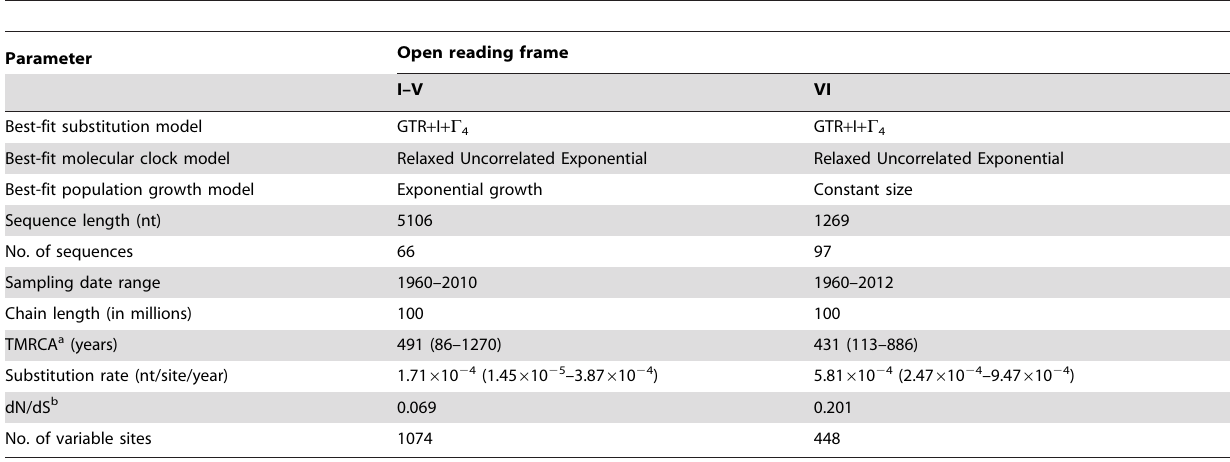
Table 2. Details of the data sets used for estimation of nucleotide substitution rate and time to the most recent common ancestor for Cauliflower mosaic virus